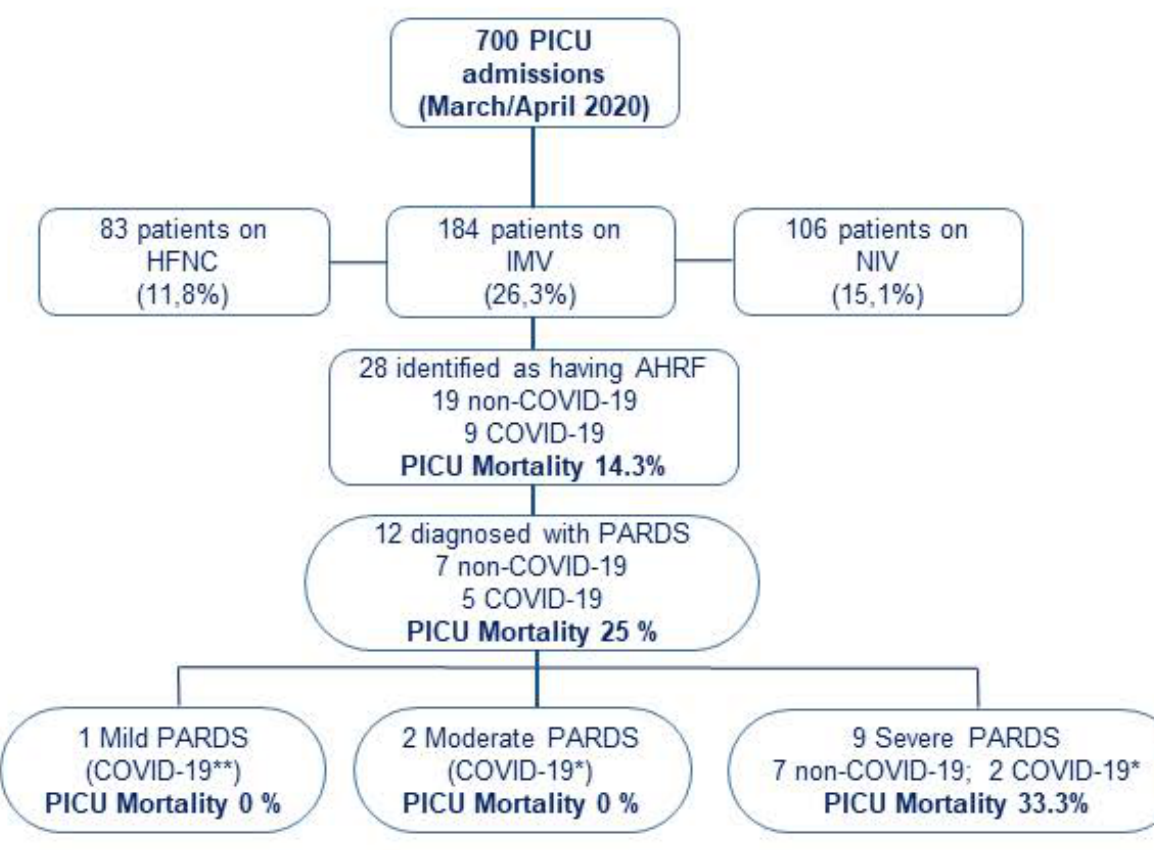
Figure 1. Patients flowchart. Patients who fulfilled study criteria of PaO 2 /FiO 2 ≤ 300 mmHg or SpO 2 /FiO 2 ≤ 264 mmHg on invasive mechanical ventilation with a positive end-expiratory pressure (PEEP) ≥ 5 cmH 2 O, and with a FiO 2 ≥ 0.3 were included in the study. Patients who met PARDS criteria were stratified according to PALICC PARDS definition. All other patients were ineligible. * COVID-19: COVID-19 patients without MIS-C. ** COVID-19: COVID-19 patients with MIS-C. PICU: Pediatric Intensive Care Unit. HFNC: High Flow Nasal Cannula; IMV: Invasive Mechanical Ventilation; NIV: Non-invasive Mechanical Ventilation; AHRF: Acute Hypoxemic Respiratory Failure; PARDS: Pediatric Acute Respiratory Distress